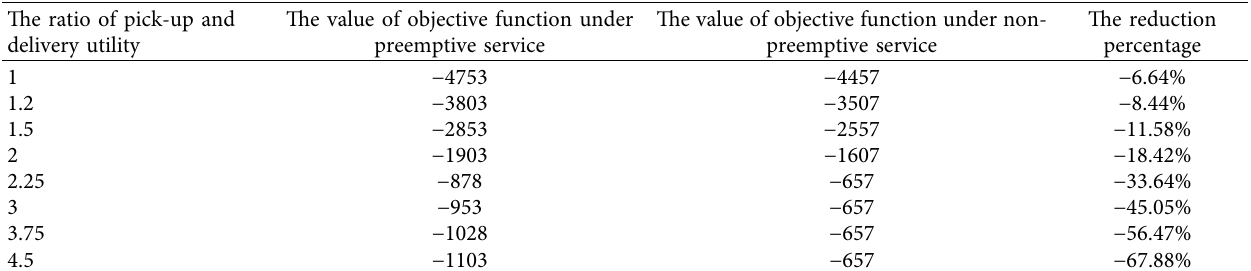
Table 15: The solution results under different ratios of pick-up & delivery utility.